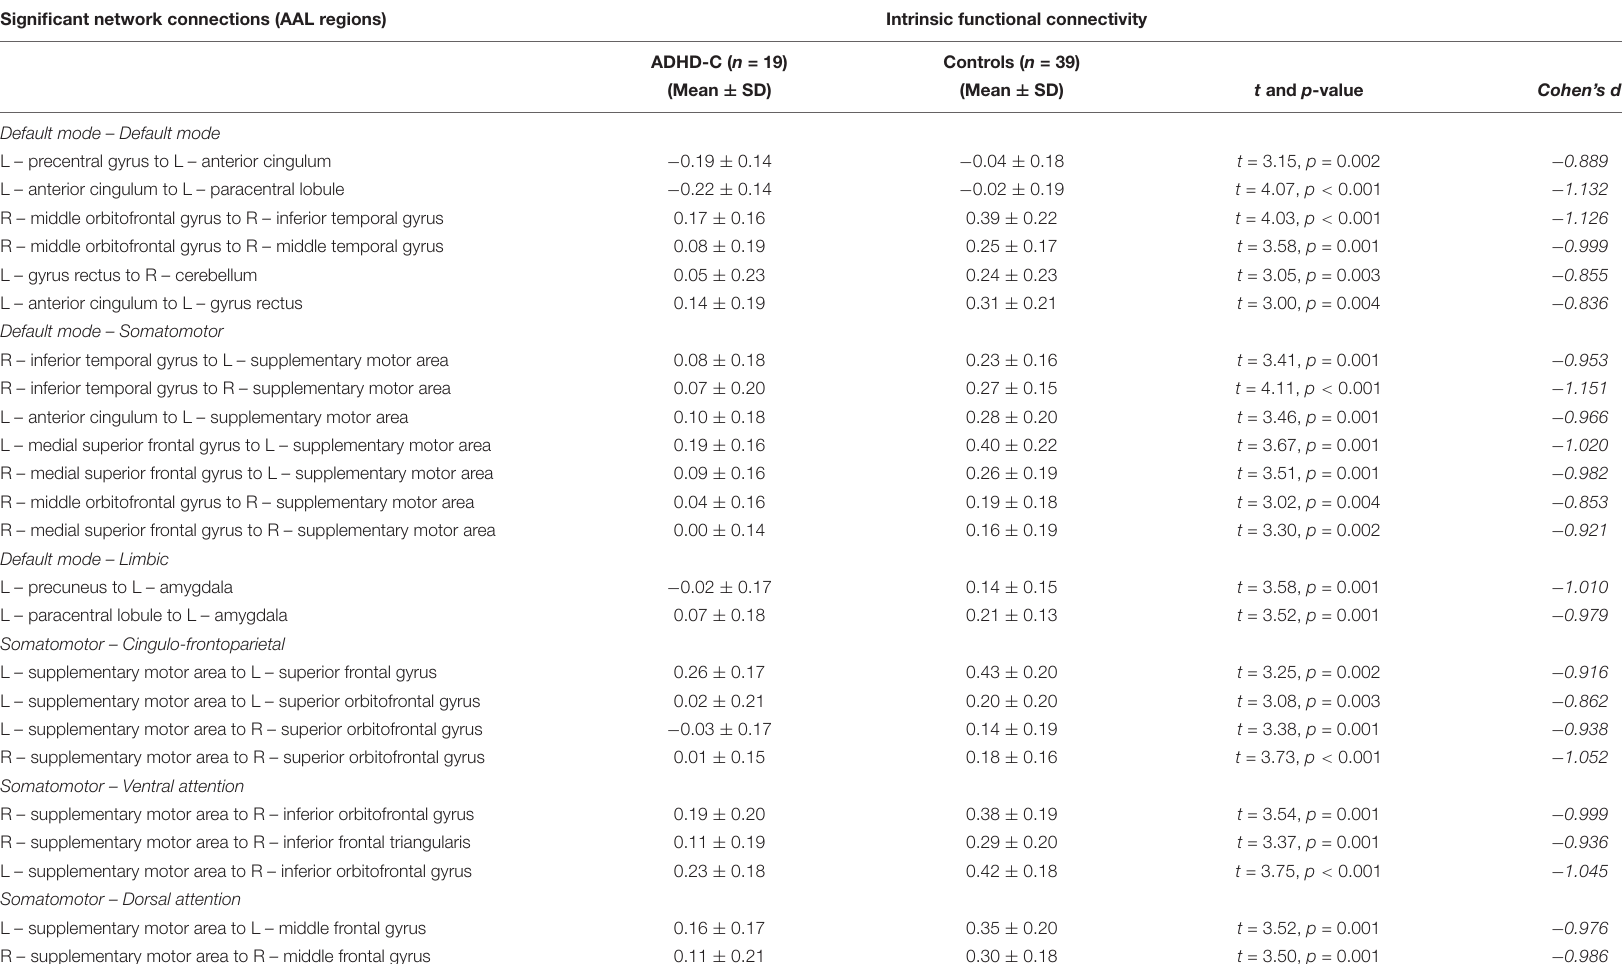
TABLE 2 | Networks identified to be significantly different between the ADHD-C and control groups using network-based statistical analysis. Significant network connections (AAL